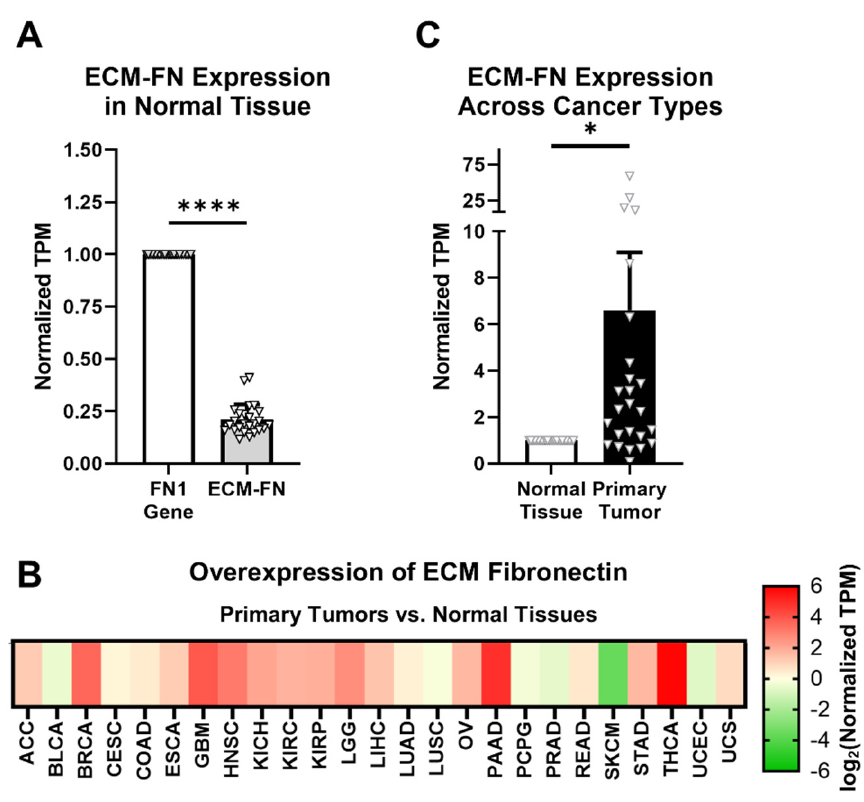
Figure 3. ECM-FN expression in primary tumors. ( A ) Expression of the 10 ECM-FN transcripts normalized to the whole FN1 gene in primary tumors ( n = 25). ( B ) Overexpression of ECM-FN mRNA in primary tumors versus normal tissues ( n = 25). Cancer types were excluded from analysis if the number of samples in either the primary tumors or normal tissues was fewer than 10. ( C ) Average overexpression of ECM-FN mRNA in primary tissues versus normal tissues. Significance: *, p < 0.05; ****, p < 0.0001.